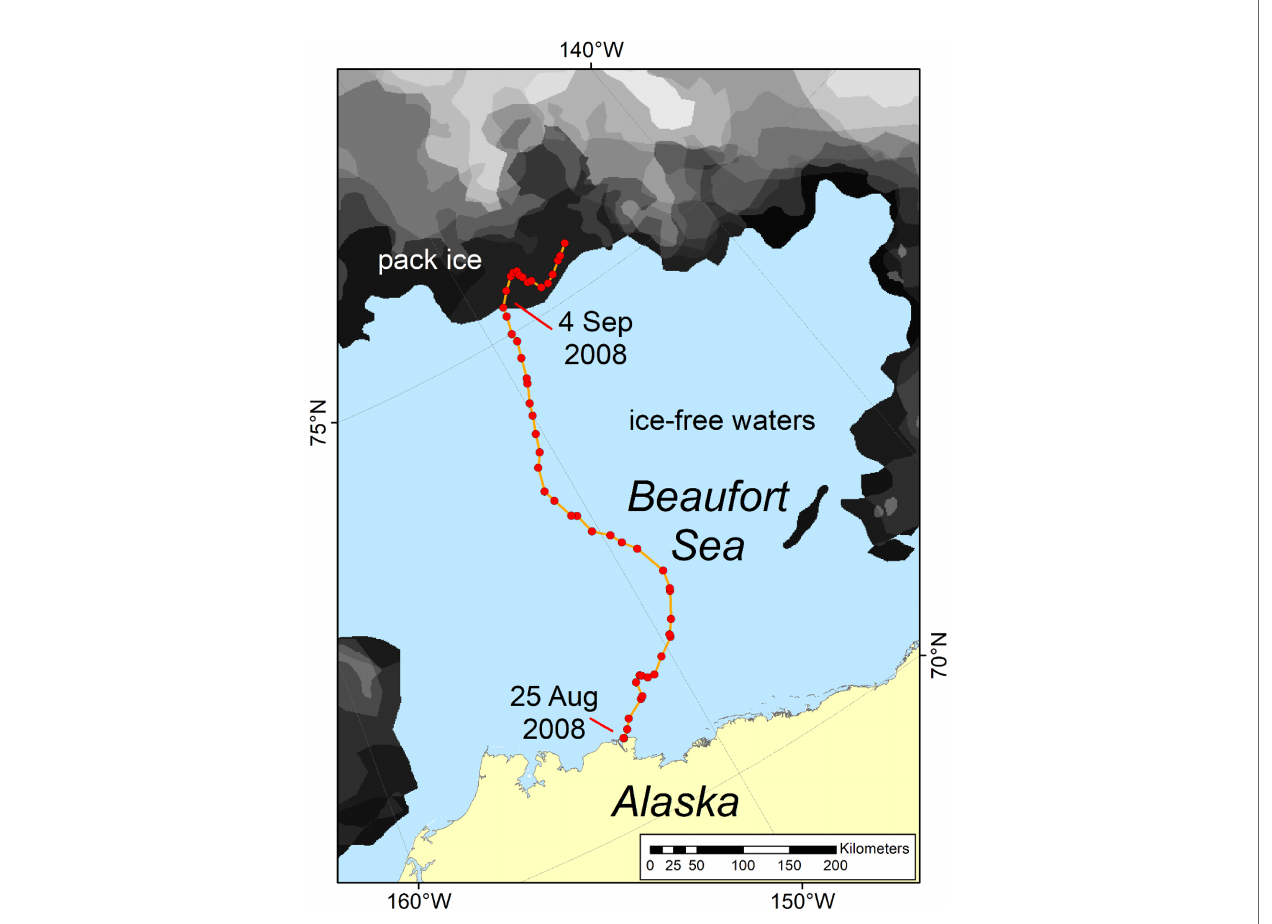
FIGURE 6 | Track of a satellite-collared adult female polar bear that swam north from Alaska (Southern Beaufort Sea subpopulation) through ice-free waters from 25 August to 4 September 2008. For details see Durner et al.